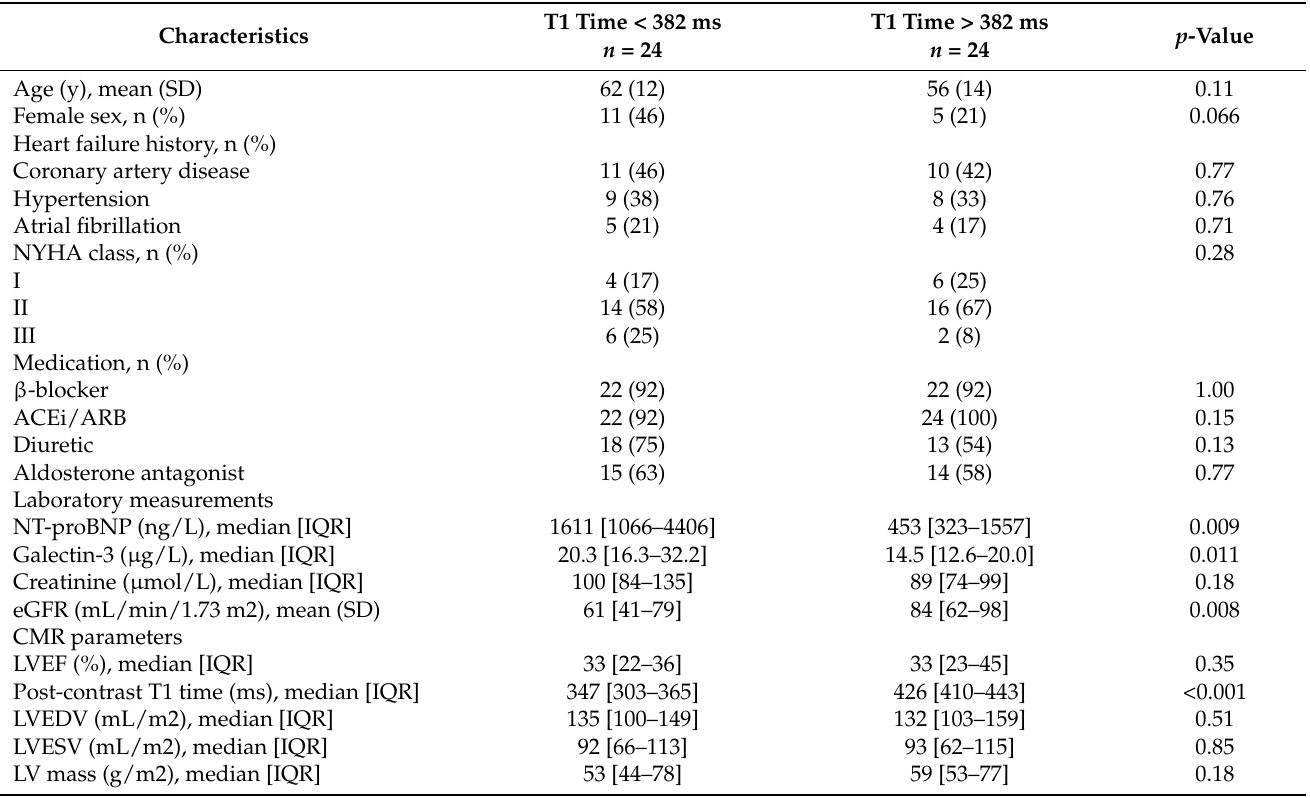
Figure 3. Biomarker levels of NT-proBNP and galectin-3 in LGE-positive patients stratified based upon median post-contrast T1 time of the non-infarcted myocardium. * p < 0.05, ** p < 0.01. Table 2. Baseline characteristics of LGE-positive patients, divided by median post-contrast T1 time.